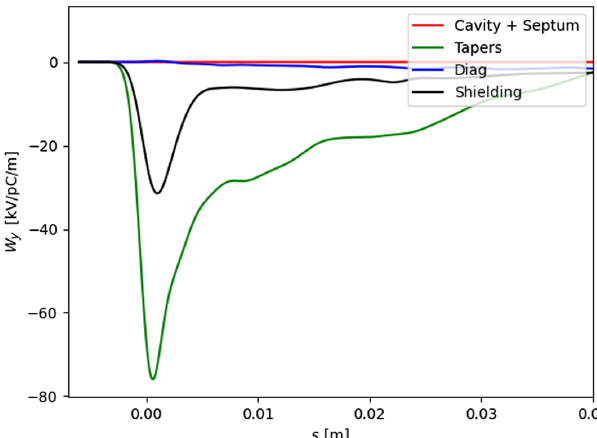
It can be seen that the small aperture BPMs have a strong contribution to the horizontal wake potential. The BPM buttons required impedance optimization due to the fact that they created a narrow band resonator. The radius of the buttons needed to be modified to reduce the shunt imped- ance of the resonator to below the threshold for coupled bunch